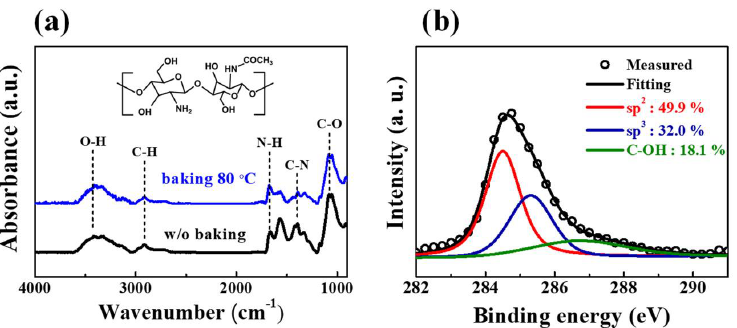
Figure 3. ( a ) FT-IR spectra of the chitosan electrolyte. Inset is the molecular structure of the chitosan electrolyte. ( b ) XPS C1s peak of the single-walled carbon nanotubes (SWCNTs).